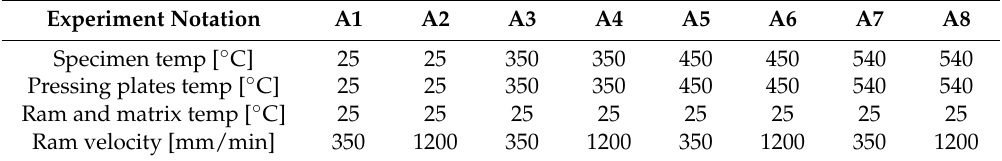
Table 1. Upsetting experiment parameters for cylindrical specimens: Initial temperatures and ram velocity. Experiment Notation